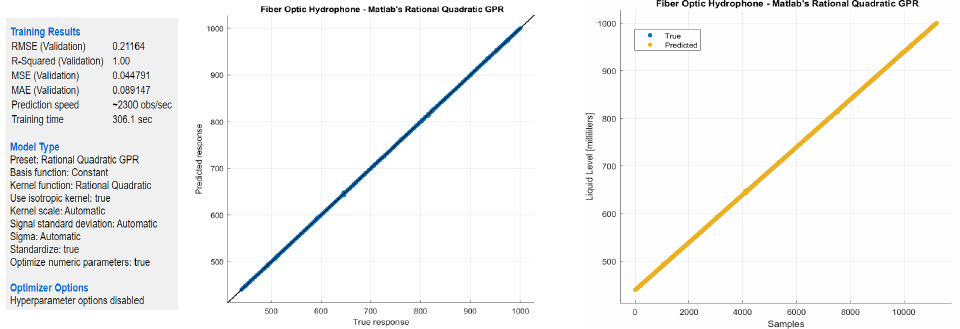
Figure 23. Gaussian process regression (rational quadratic) for the FOH system.